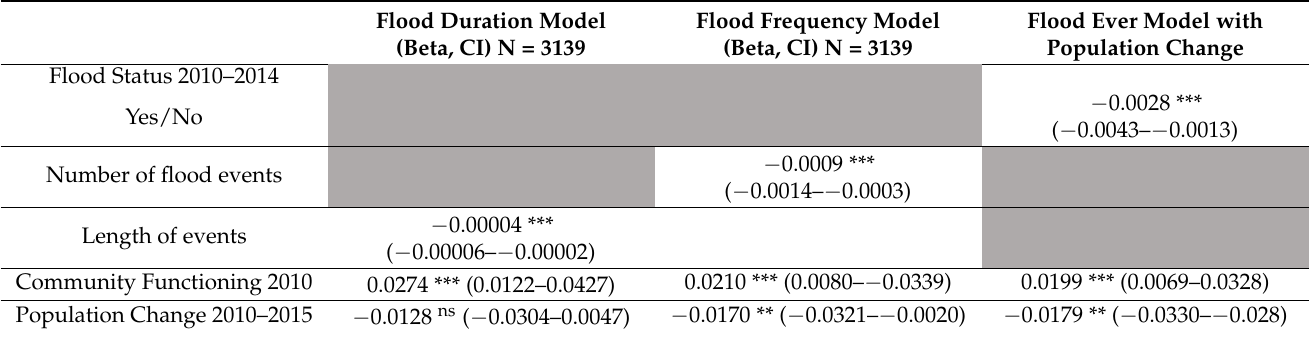
Table 4. Multivariate models of CF trend (2010–2015) in counties with a FEMA-related flood event.